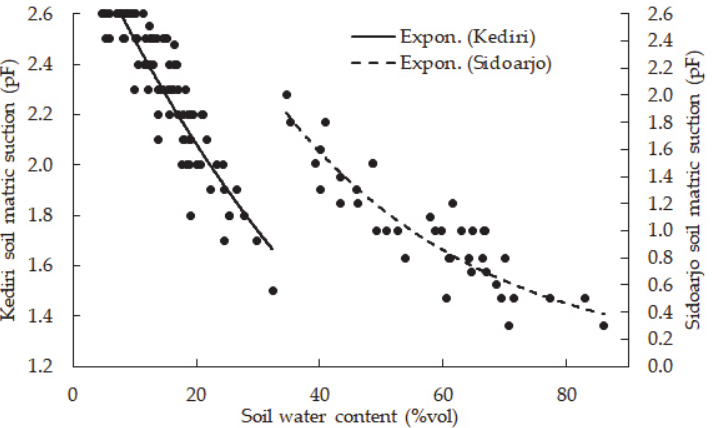
Figure 5. Soil water retention curve (SWRC) based on field observations and measurement in Kediri and Sidoarjo plantations.